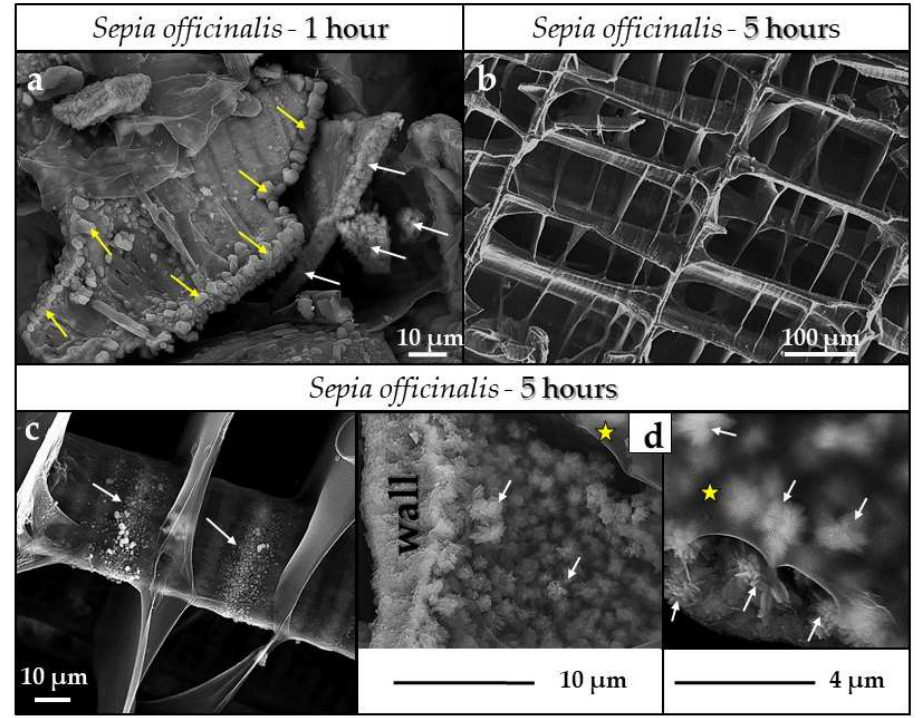
Figure 7. FE-SEM images showing Sepia officinalis cuttlebone altered for ( a ) 1 h and ( b – d ) 5 h. Even as early as 1 h of alteration of the cuttlebone, aragonite within skeletal elements starts to be converted to AP (white arrows in ( a )), in addition to some newly formed crystals (black arrows in ( a )) that precipitate onto skeletal element surfaces. At 5 h of conversion of aragonite to AP, AP formation within skeletal elements proceeds rapidly further (white arrows in ( d )). In addition, newly formed AP starts to cover the surface of skeletal elements (white arrows in ( c ). Yellow stars in ( d ) point to the biopolymer lining that covers the surface of a skeletal element, in this case, a wall.